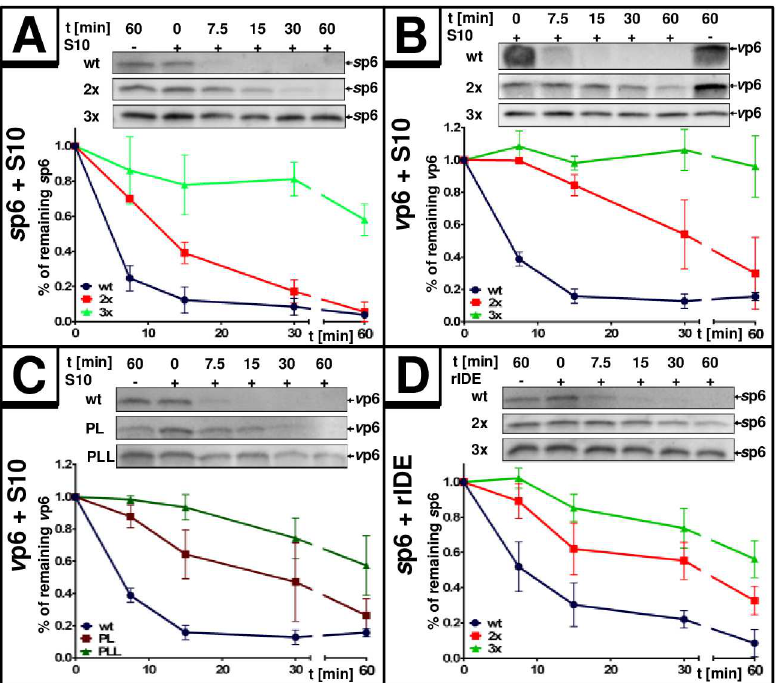
Fig 9. Multiplication of PTAPPA-motifs stabilizes p6. 20 ng of s p6 or 30 ng of v p6 were incubatedeither with 5 μ g S10 extract (A/B/C) or 2 ng of rIDE (D) for up to 60 min. Degradation efficiency was quantified via densitometric analysesof Western blots. Valuesrepresent the arithmetic mean ± SD of at least 3 independent experiments for each setting.